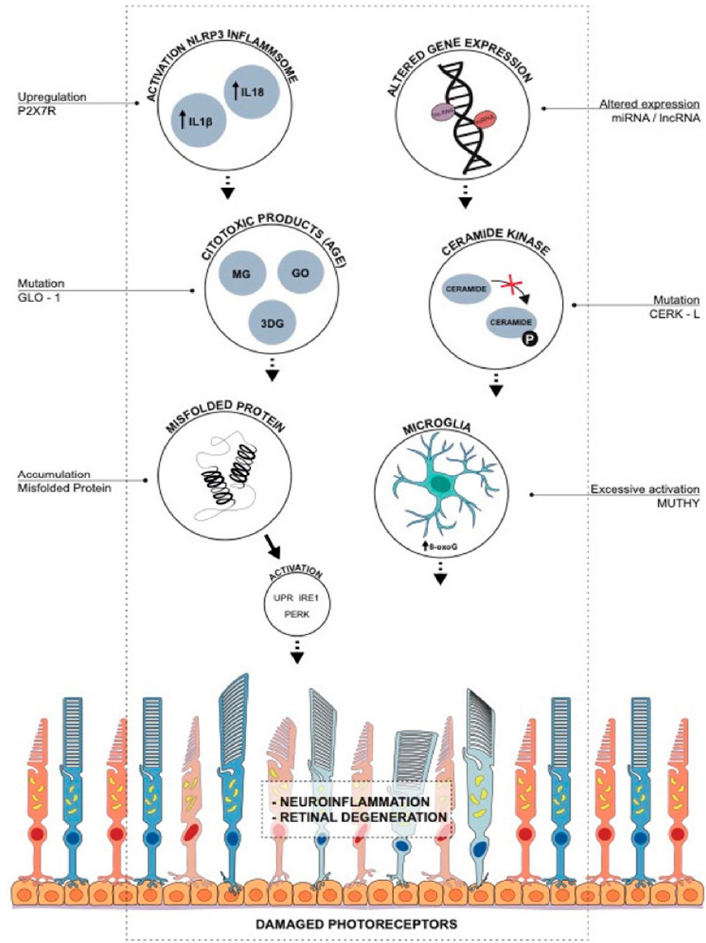
Figure 3. Oxidative stress-induced molecular mechanisms of retinal degeneration in retinitis pigmentosa. Upregulation of P2X7R leads to inflammasome activation, the release of proinflammatory cytokines, and retinal degenerative diseases. Glyoxalase 1 (GLO1) regulates ROS generation and advanced glycation end products (AGE), and mutation in GLO-1 leads to accumulation of AGEs and retinal degeneration. Accumulation of misfolded proteins causes an increase in ROS, enhancing unfolded protein response (UPR), PERK (PKR-like endoplasmic reticulum kinase), and IRE1 (inositol-requiring enzyme 1) pathways in photoreceptor cells leading to retinal degeneration. Ceramide-kinase-like (CERKL) gene induces the phosphorylation of ceramide and protects the cell from oxidative stress-induced apoptosis. An increase in CERKL mutation leads to increased apoptosis and RP. Altered expression of micro-RNAs (miRNAs) and long non-coding RNAs (lncRNAs) by oxidative stress in retinal pigmental epithelial cells induces biochemical pathways involved in RP pathogenesis. MUTYH (mutY DNA glycosylase) is responsible for the maintenance of genomic integrity, and excessive activation of MUTYH leads to the formation of single-strand breaks of DNA, causing disturbed homeostasis and cell death. Adapted from Gallenga et al.